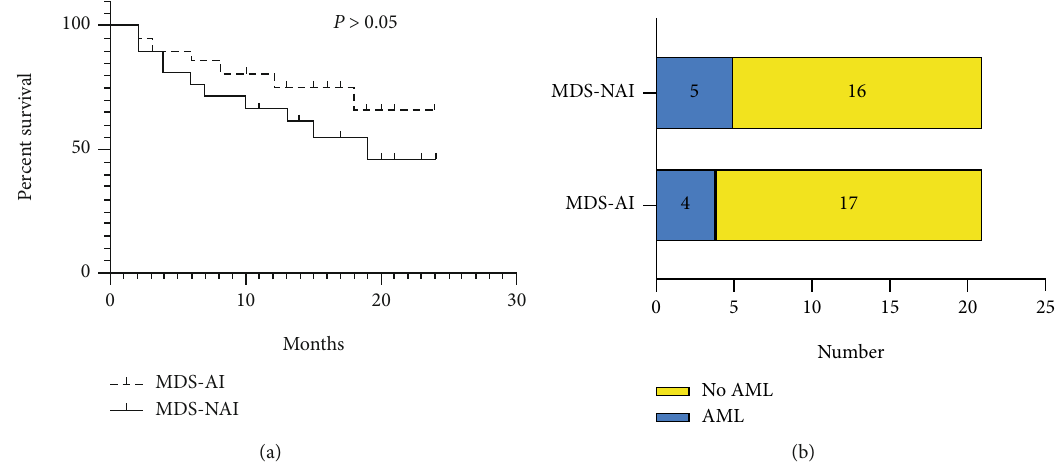
Figure 5: The survival time and transformation to AML of newly diagnosed MDS-AI and MDS-NAI. (a) The survival time of newly diagnosed MDS-AI and MDS-NAI ( P > 0 : 05 ). (b) The transformation to AML of newly diagnosed MDS-AI and MDS-NAI ( P > 0 : 05